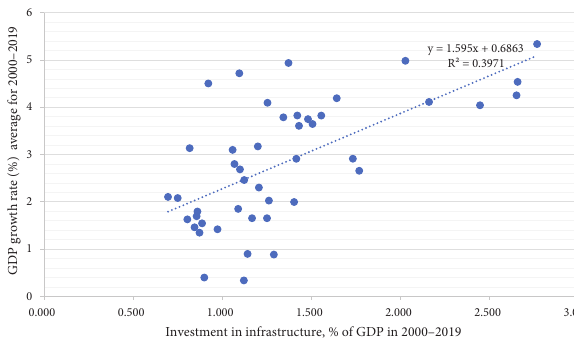
Figure 1. Average GDP growth rate and investment in infrastructure 2000 – 2019 (sources: OECD iLibrary,